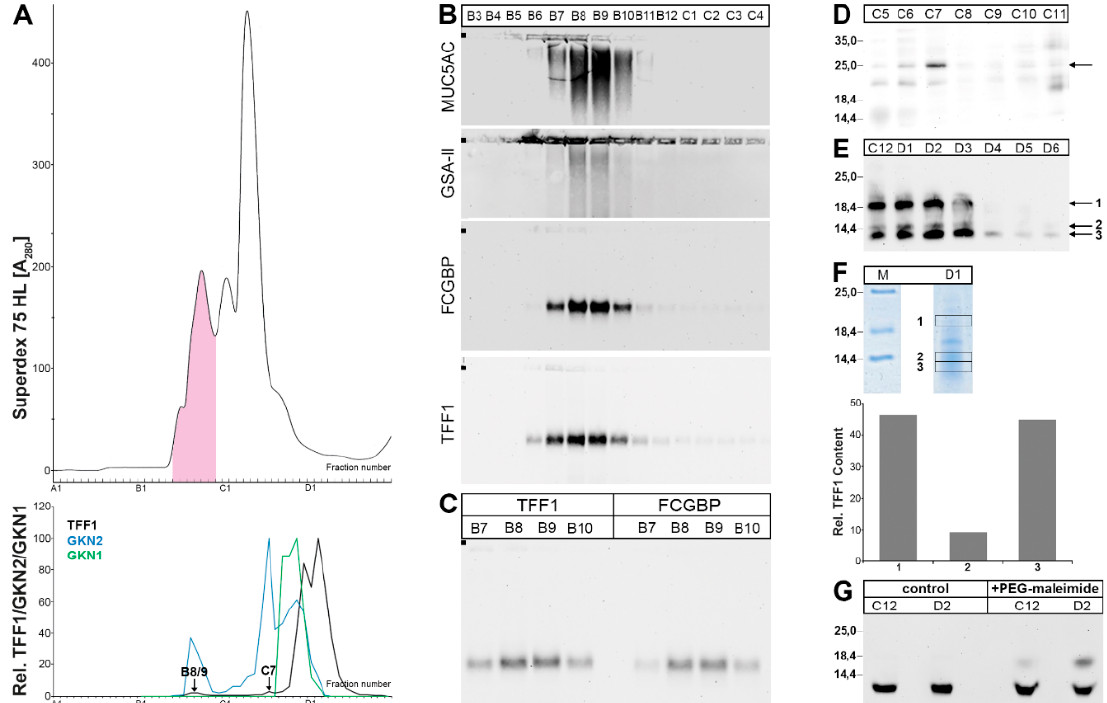
Figure 1. Analysis of human gastric corpus extract (M C -383; homogenized in a mortar). ( A ) Elution profile after size exclusion chromatography (SEC) on a Superdex 75 HL column, as determined by absorbance at 280 nm (periodic acid-Schiff (PAS)-positive mucin fractions: pink). Underneath: Distribution of the relative TFF1 (black), GKN2 (blue), and GKN1 (green) content as determined by monomeric band intensities. ( B ) 1% agarose gel electrophoresis (AgGE) and subsequent Western blot